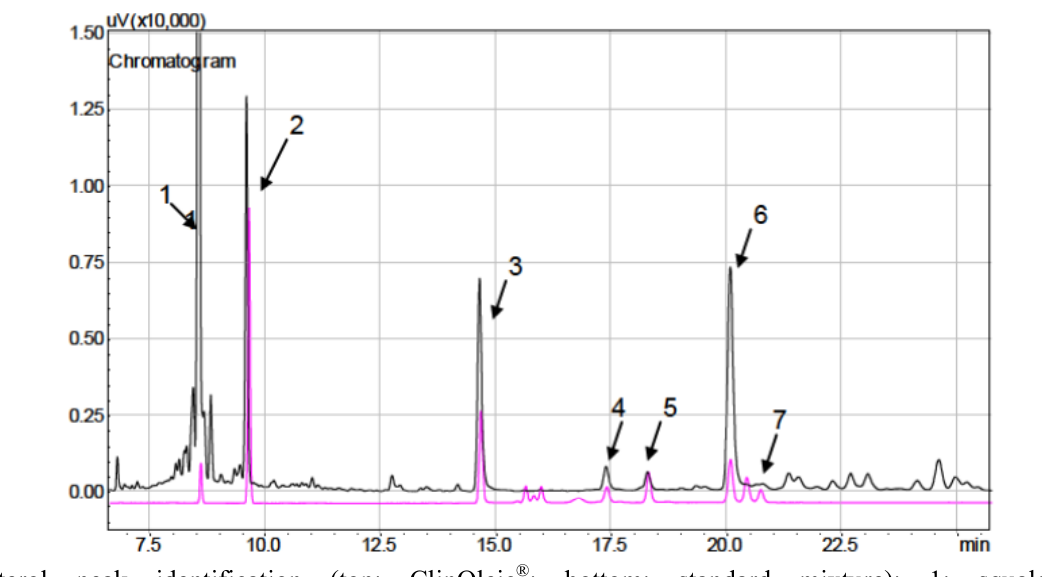
Figure 3. Gas chromatograph of the ClinOleic ® lipid